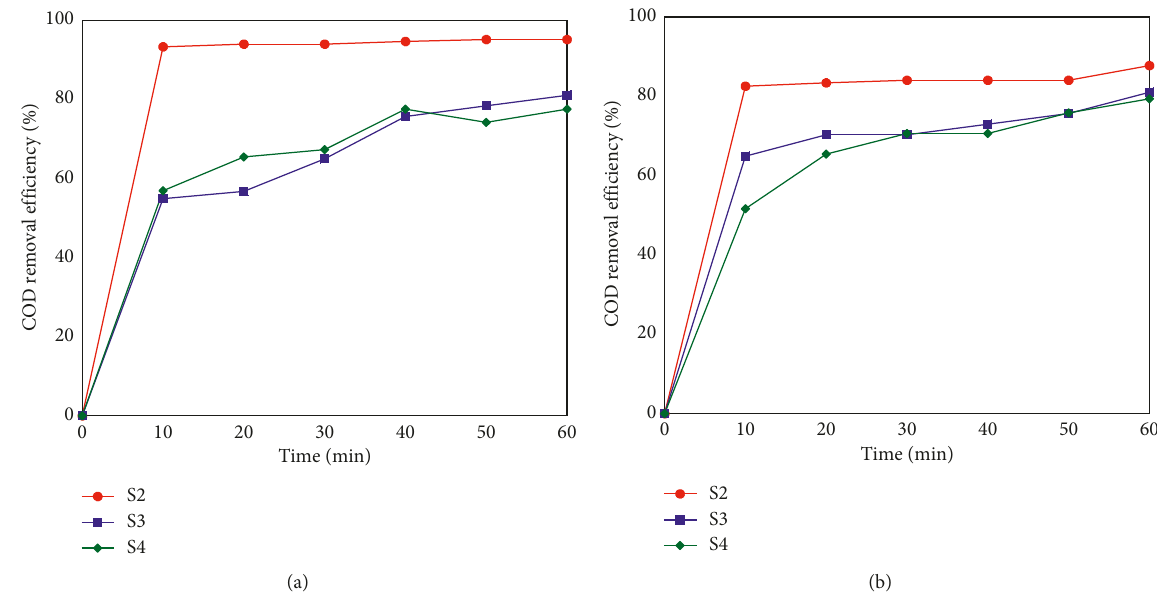
Figure 4: Removal efficiency of COD for an EC process with (a) Fe electrode and (b) Al electrode. Conditions: pH 7.0; S2 (tanning), S3 (retanning), and S4 (mixture) wastewater; electrolysis time �